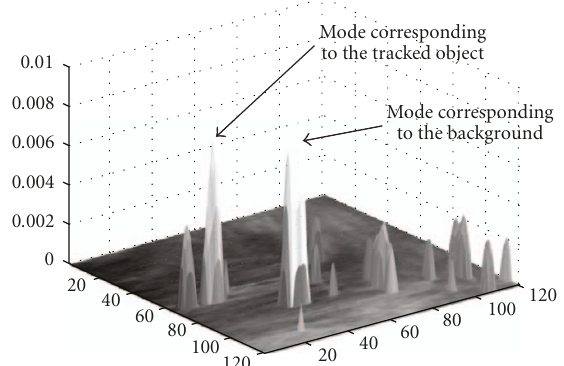
Figure 3: Likelihood distribution related to Figure 2.